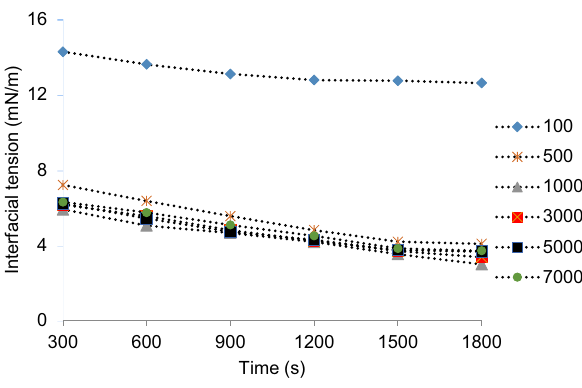
Fig. 6 Dynamic interfacial tension curves of AN-120 solution at various concentrations with formation water base and crude oil at 351.15 K and pressure of 14.7